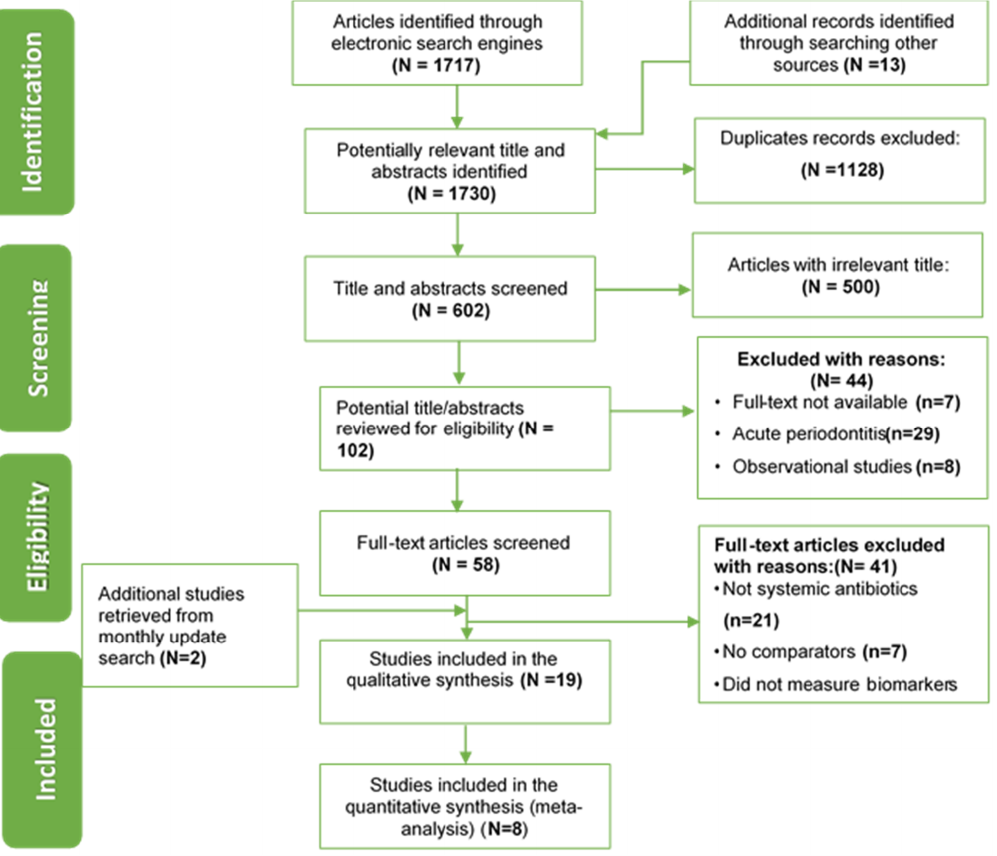
Figure 1. Search results for studies on the effect of antibiotics in addition to mechanical debridement among adults with chronic periodontitis